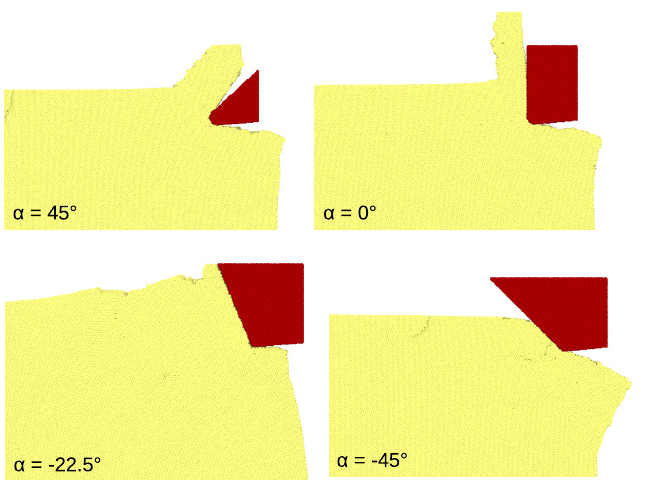
Figure 5. Side views of the chips formed during